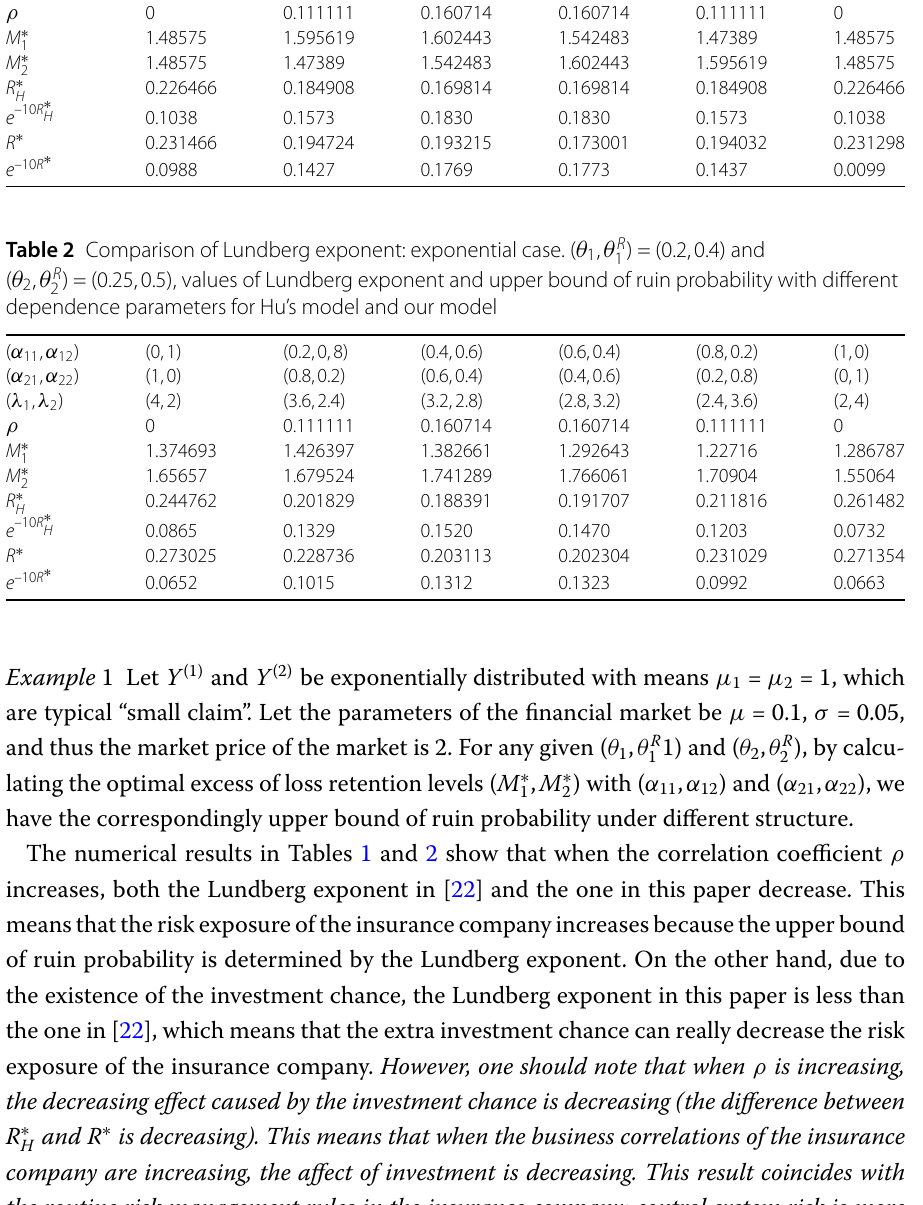
Table 1 Comparison of Lundberg exponent: exponential case. ( θ 1 , θ R Lundberg exponent and upper bound of ruin probability with different dependence parameters for Hu’s model and our model